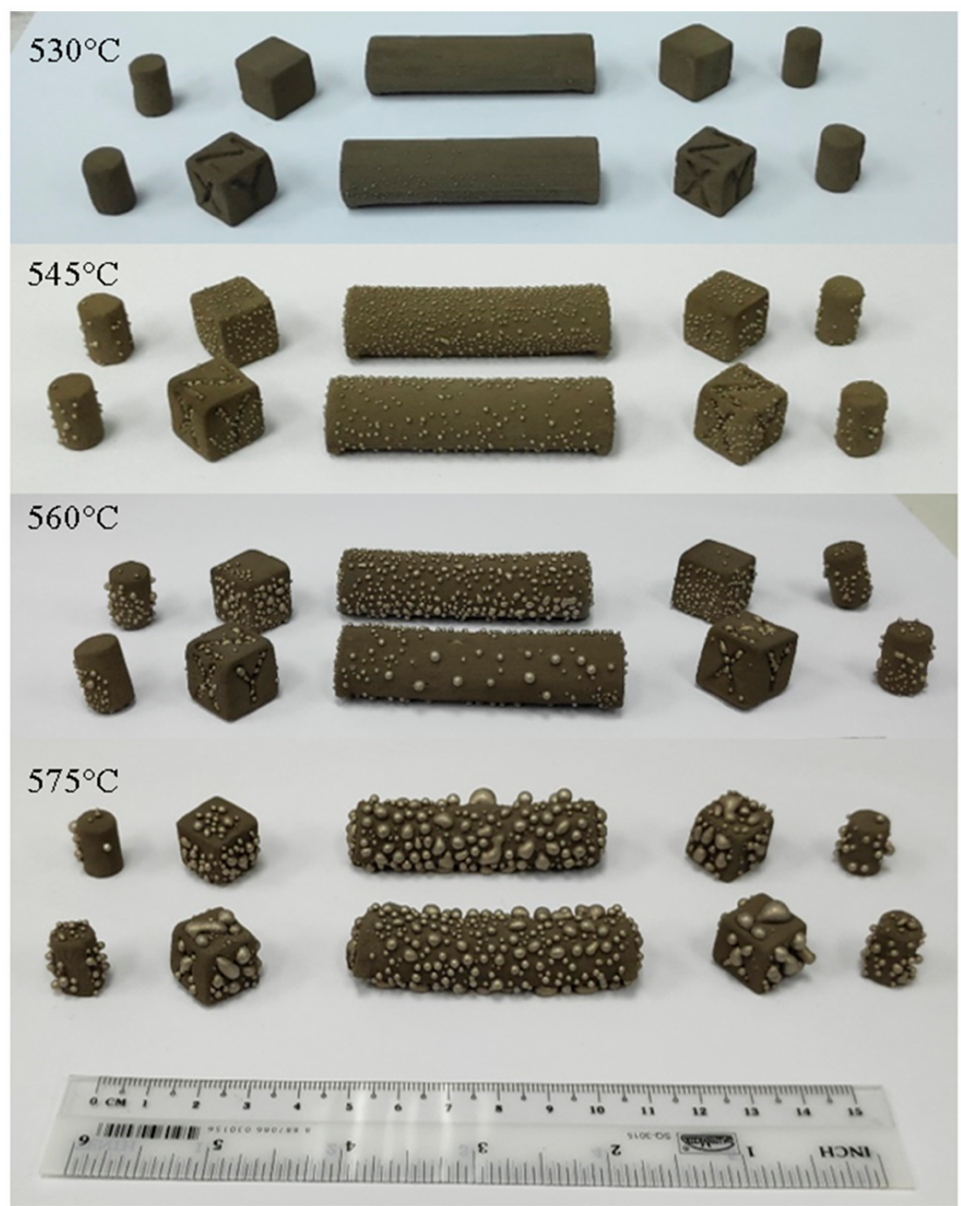
Figure 9. Macrographs of as-printed objects with different sizes and geometries after sintering at various temperatures for 5